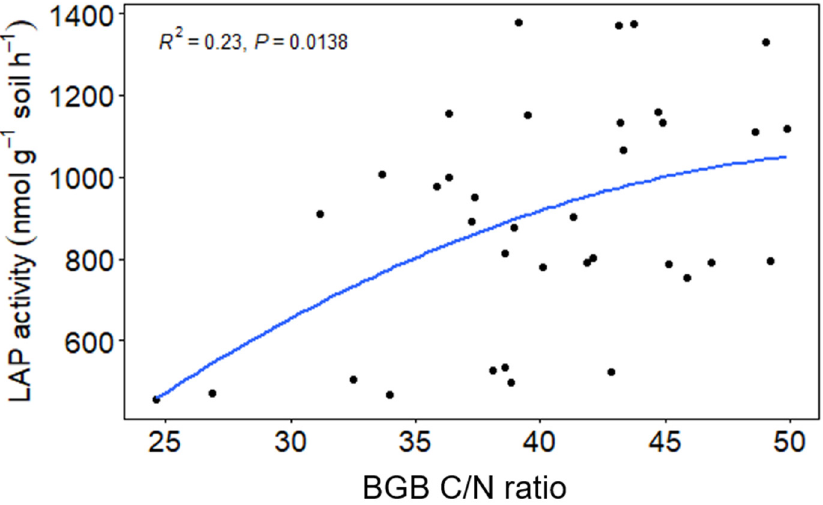
Figure 3. A quadratic response curve showing the relationship between the microbial enzyme (LAP) activity and belowground biomass C/N ratio.